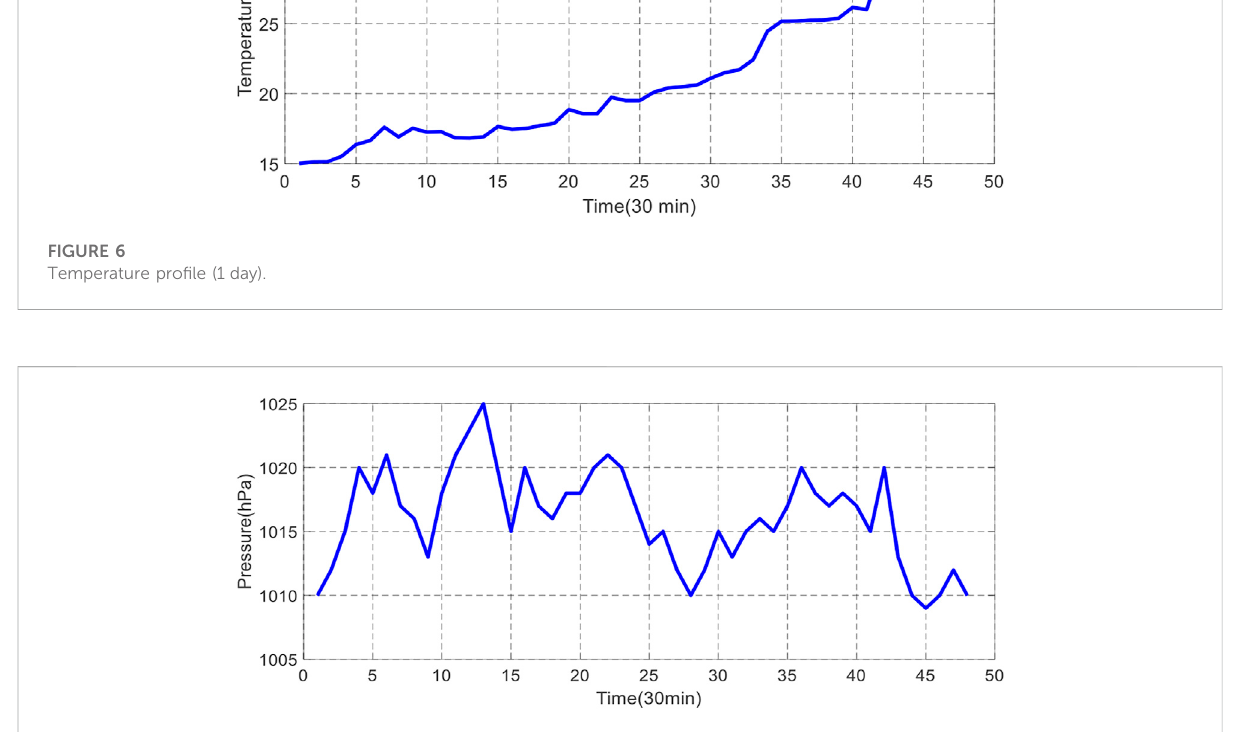
FIGURE 7 Pressure pro fi le (1